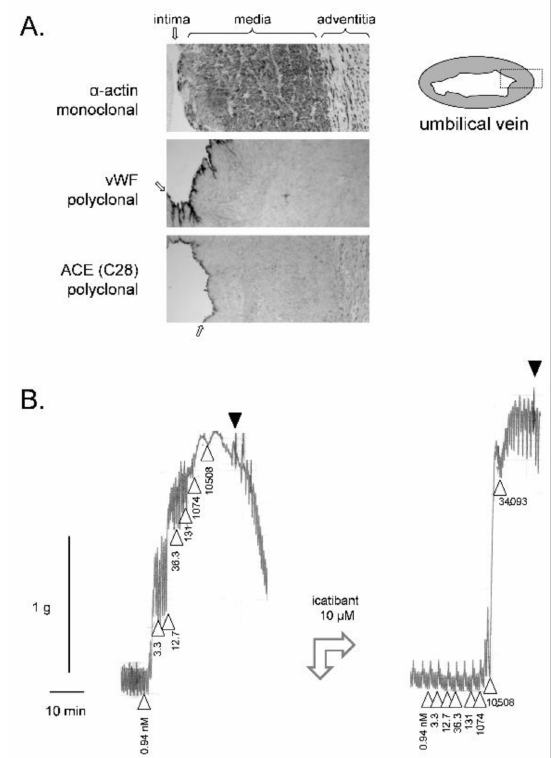
Figure 1. ( A ) Immunohistochemistry for angiotensin-I converting enzyme (ACE) and cell markers (monoclonal anti- α -actin for the smooth muscle cells, polyclonal anti-von Willebrand factor (vWF) for the endothelium) in paraffin sections of the human umbilical vein (100 × , approximate width of rectangular fields 700 µ m). The dark precipitates indicate positive cells. The position of tunicae intima, media and adventitia are indicated (the intima by arrows). Modified from [63] with permission. ( B ) Left: Construction of a cumulative concentration–effect curve for BK-induced contraction by using a ring of human umbilical vein pre-equilibrated for 3 h. Abscissa scale: time; ordinate scale: isometric contraction, grams. (cid:52) indicates the application of BK (cumulative nanomolar concentration indicated) and (cid:72) the first of a series of washouts. Right tracing recorded in the same tissue at time 5 h: the antagonist icatibant at a high concentration reduced the sensitivity to BK, but not its maximal effect. This experiment was part of a project approved by the local ethics committee (CHU de Qu é bec-Universit é Laval, File no. 2017-3720). Umbilical cords were obtained following elective caesarean sections. Informed consent was obtained from the